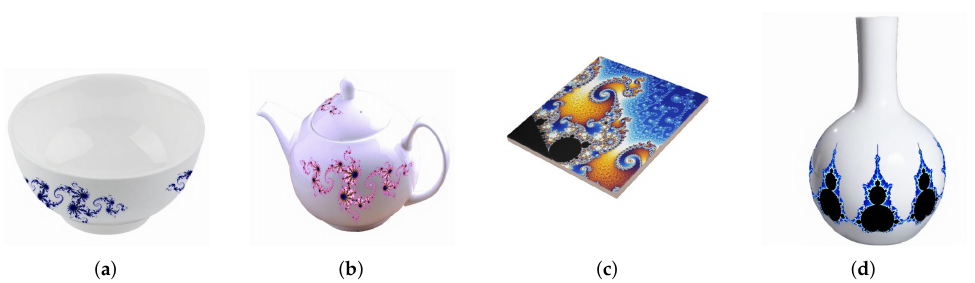
Figure 19. Mandelbrot and Julia fractals on ceramics products. ( a ) Julia bowl, ( b ) Julia teapot, ( c ) Mandelbrot tile, and ( d ) Mandelbrot